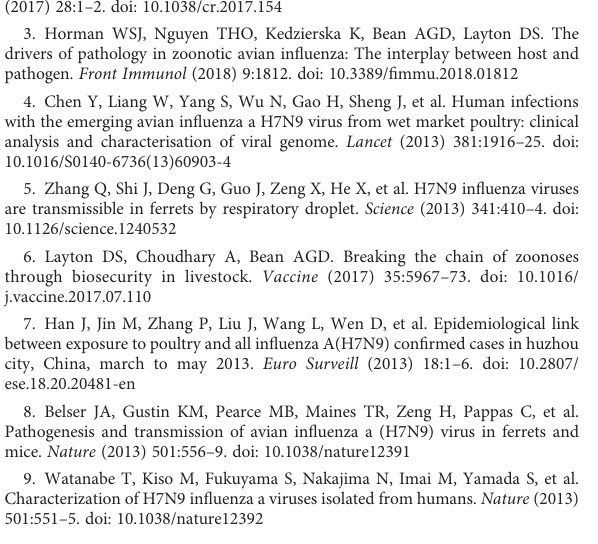
SUPPLEMENTARY FIGURE 3 Severe disease is not associated with changes in Bu1 + B cells or MHCII expression. Flow cytometry analysis of the proportions and total cell numbers in the spleen of (A) Bu1 + B cells and (B) MHCII expressing cells, comparing healthy uninfected control chickens to susceptible and resistant chickens. Error bars represent SEM. * p<0.05, ** p<0.01 SUPPLEMENTARY FIGURE 4 Relationship between MHCI splicing and haplotype. The agarose gel images show the (A) PCR product of exon 7 of chicken MHCI and (B) the PCR product of the LEI microsatellite for chickens 1-8. Band sizes were relative to a molecular weight marker MW. Based on size and sequence the LEI PCR product the haplotype has been annotated on the corresponding band. * denotes chickens that succumbed to disease. SUPPLEMENTARY FIGURE 5 SNPs in IFITM1 correlate to disease outcome. The ensembl sequence for chicken IFITM3 (A) and IFITM1 (B) are show with the corresponding sequences of chickens 1-8. Known SNPs are highlighted in red on the ensembl sequence. IFITM1 SNPs in chickens 1-8 are highlighted in red rectangles. The SNPs 1 and 2 summary for chickens 1-8 (C) are presented as a table along with disease outcome (susceptible or